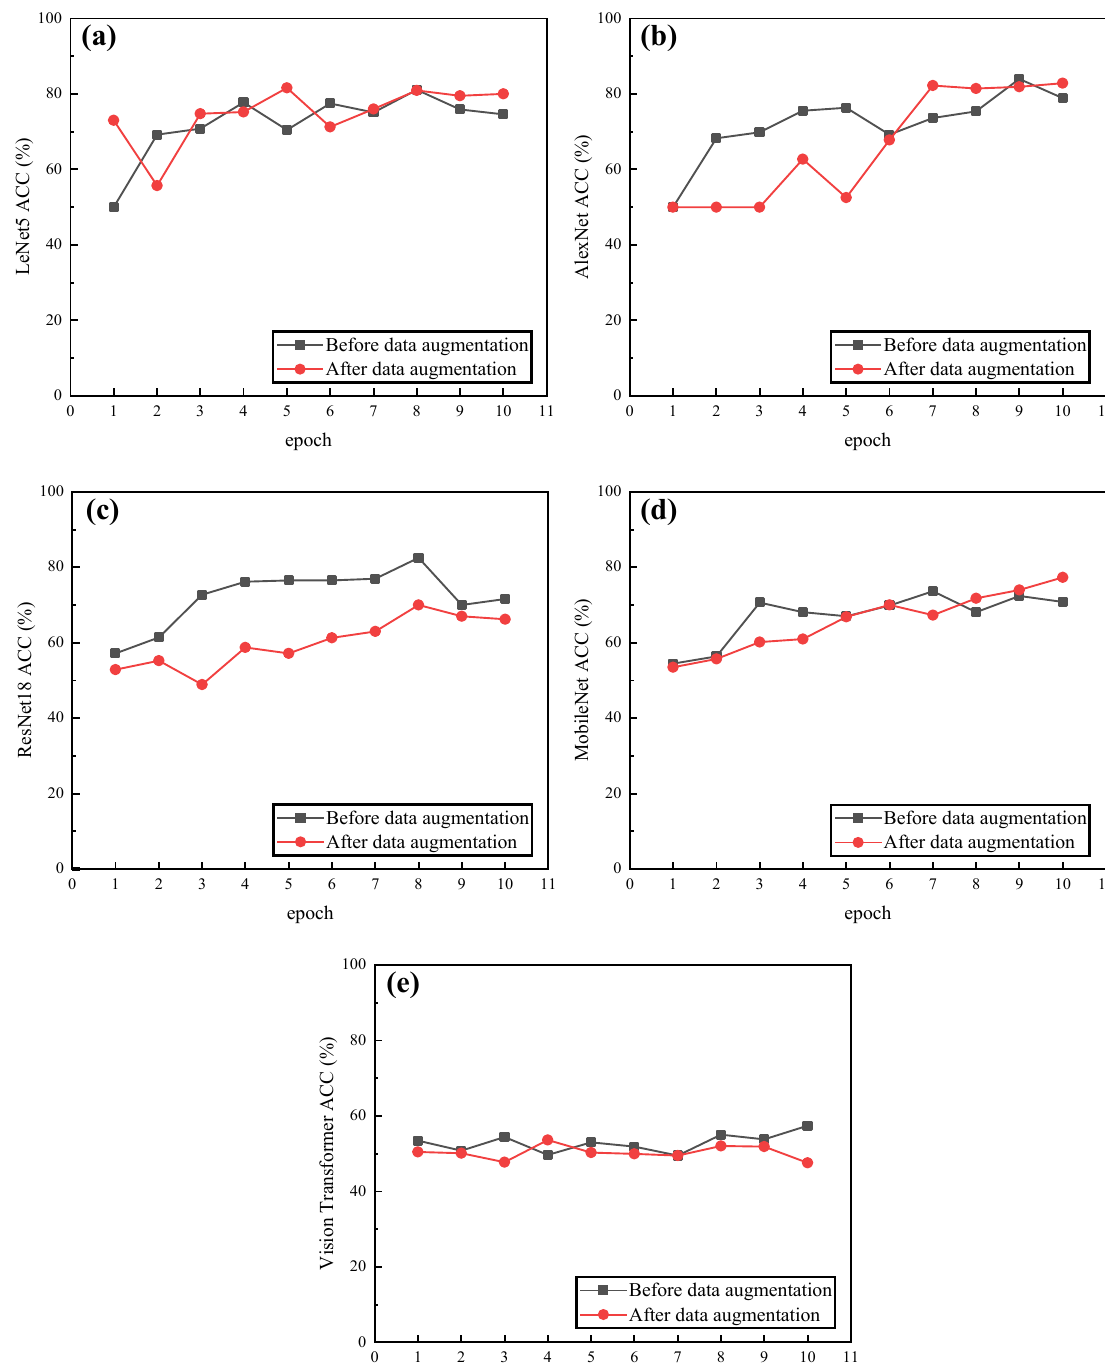
Figure 13. Comparison of accuracy of each model after GPU loading before and after data aug- mentation. ( a ) Comparison of the accuracy of LeNet5 model. ( b ) Comparison of the accuracy of AlexNet model. ( c ) Comparison of the accuracy of ResNet18 model. ( d ) Comparison of the accuracy of MobileNet model. ( e ) Comparison of the accuracy of Vision Transformer